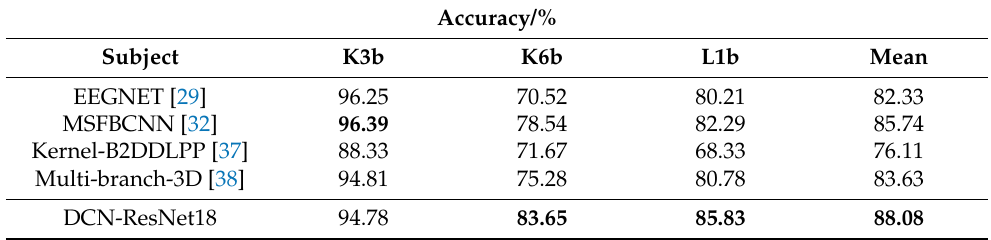
Table 8. Comparison of the recognition accuracy of different methods on BCIC III dataset 3a